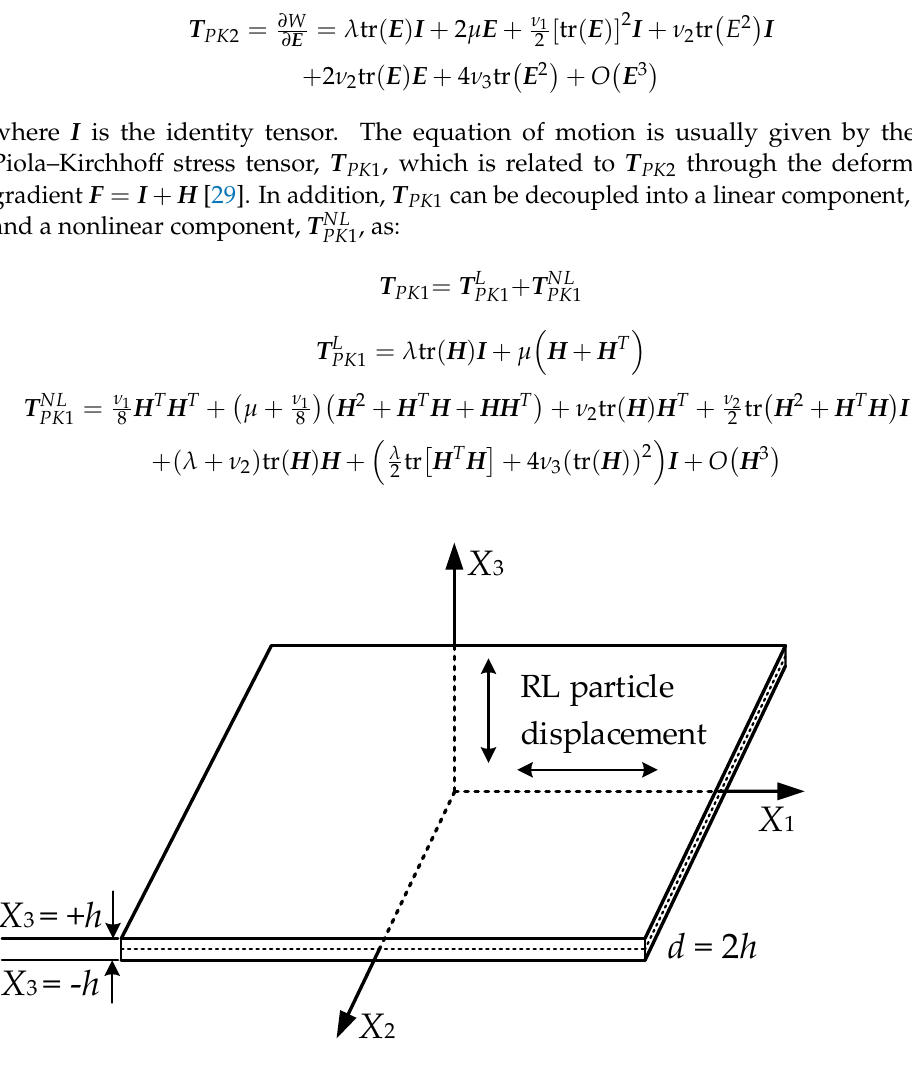
Figure 1. A free boundary plate in a reference coordinate system X 1 - X 2 - X 3 .